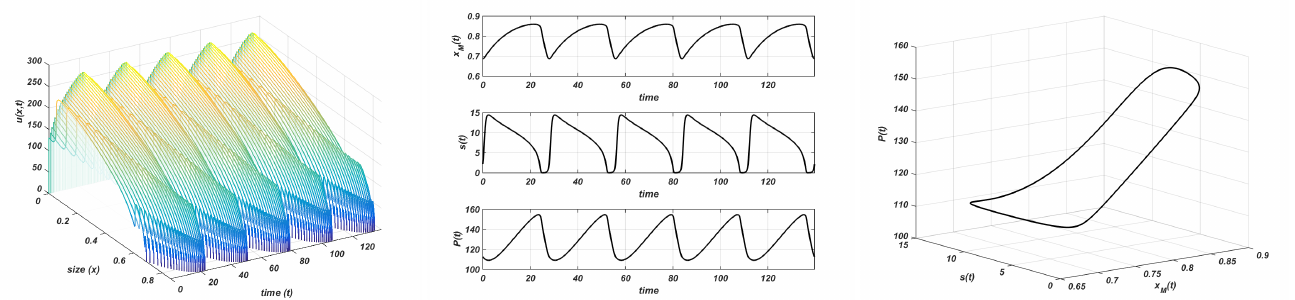
Figure 10. Gompertz growth. r = 3 and K = 20.2. Stable limit cycle. Plot on the left : evolution of the structure of the consumer; plot in the centre : evolution of the maximum size, resource, and total consumer population to the equilibrium; plot on the right : stable limit